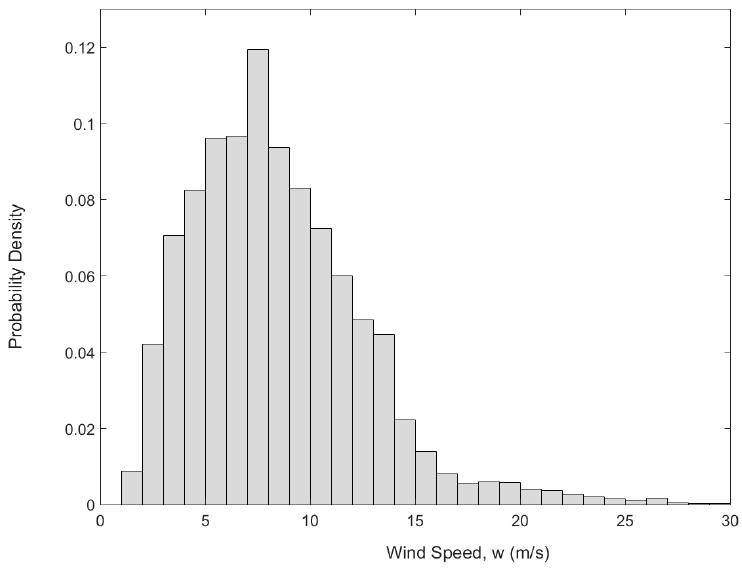
Figure 1. An example for the wind speed data in histogram format.